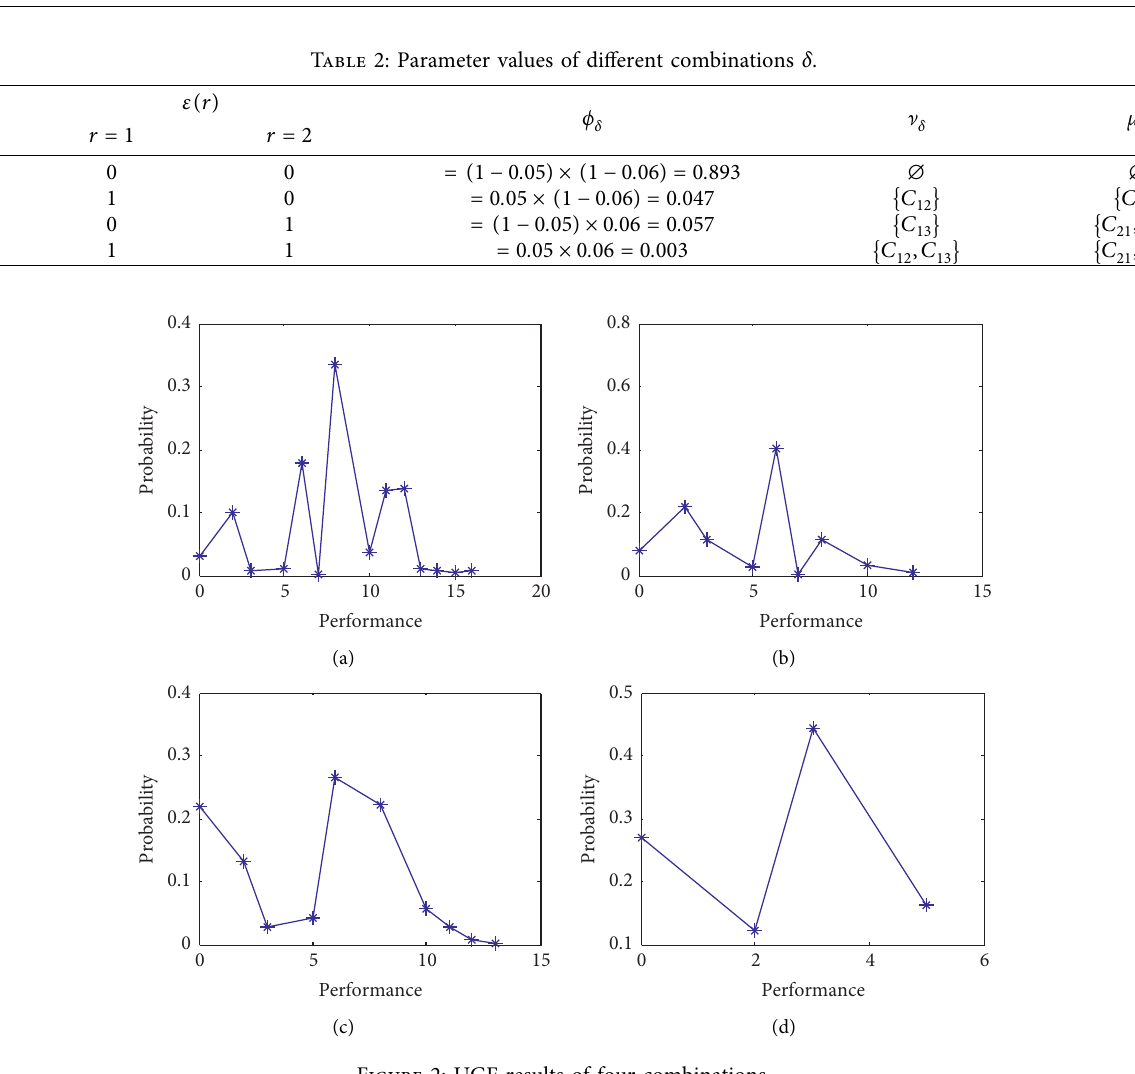
Figure 2: UGF results of four